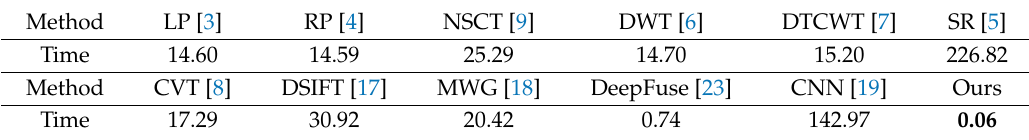
Table 4. Average running time of various methods.